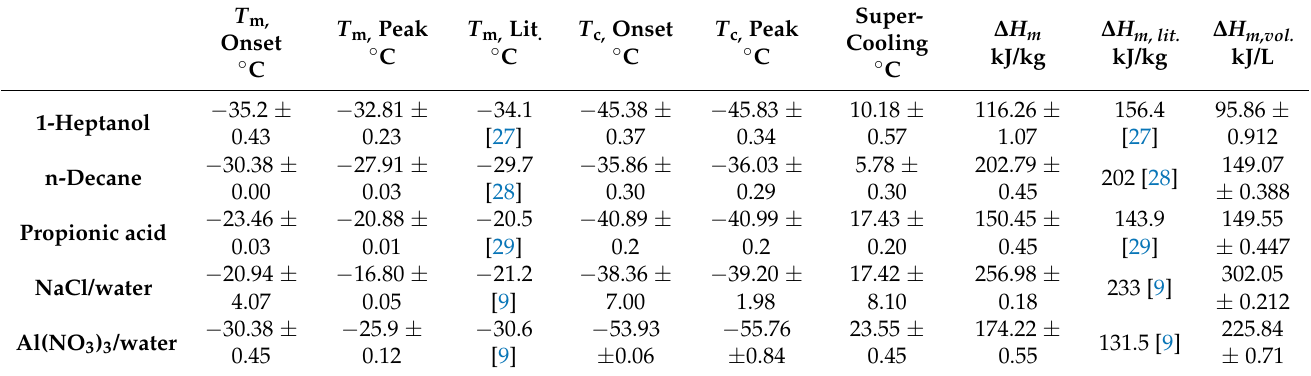
Table 3. Measured phase change temperatures and enthalpies of